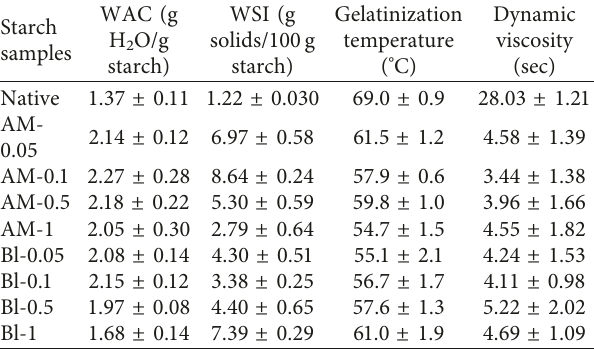
Table 3: Functional properties of native and fermented modified potato starches.